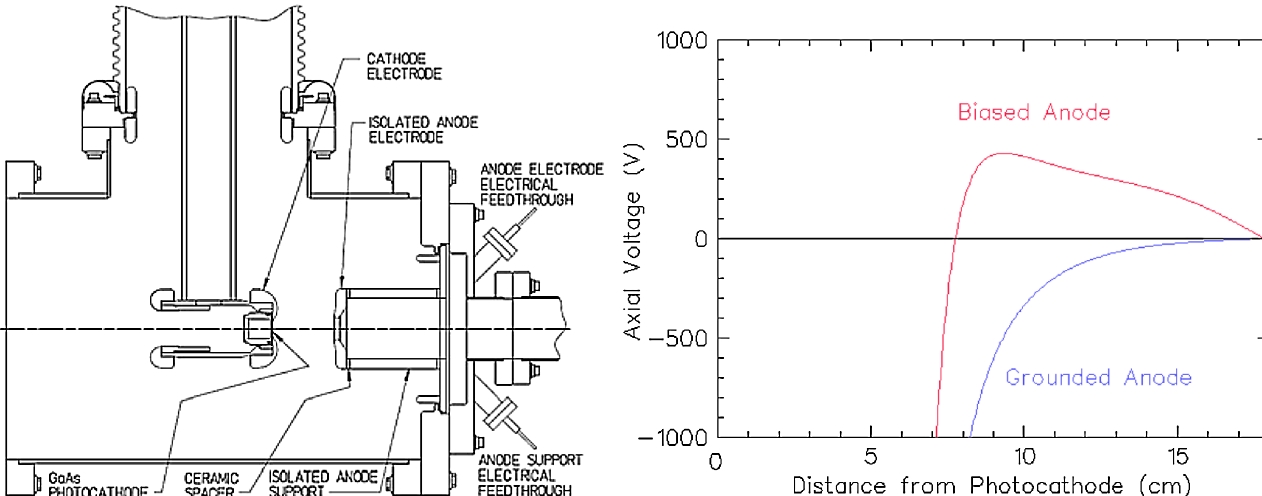
FIG. 11. Modified high voltage chamber assembly (left) and POISSON model (right) showing the potential near the anode ( (cid:3) 6 cm ) to gun exit ( (cid:3) 18 cm ) for the ‘‘attractive’’ grounded (anode electrode ¼ anode support ¼ 0 V ) and ‘‘barrier’’ biased (anode electrode ¼ þ 2000 V , anode support ¼ þ 300 V ) configurations. The potential at the photocathode (distance ¼ 0 cm ) is (cid:2) 100 kV , suppressed from the